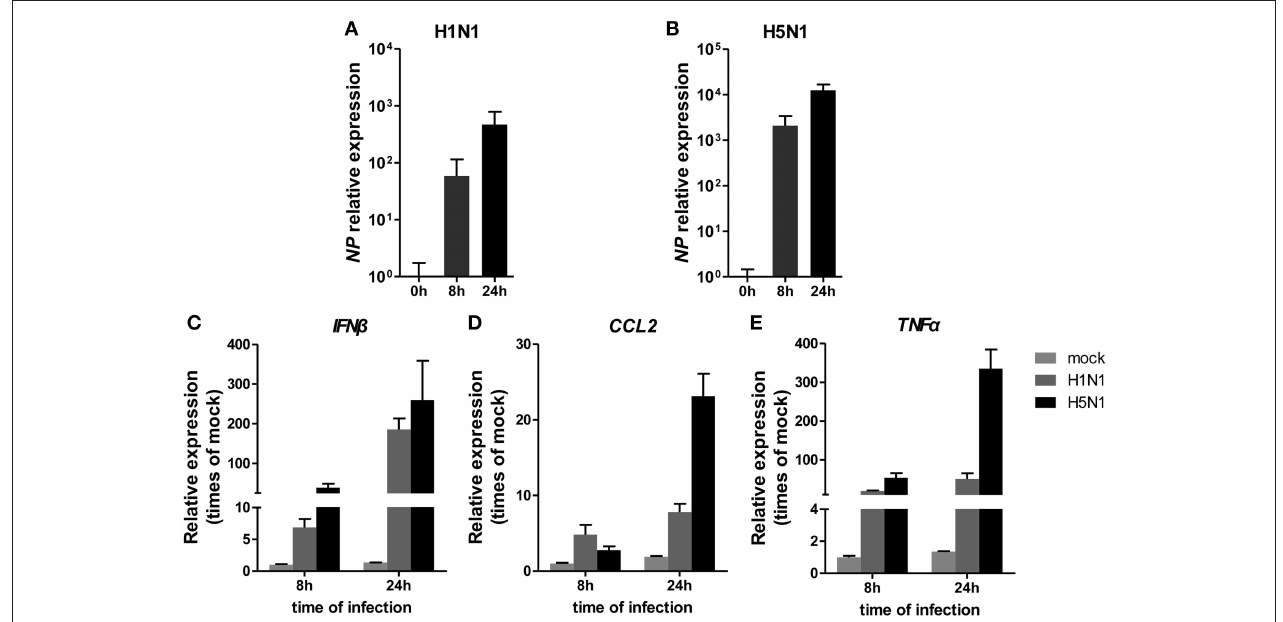
FIGURE 1 | Cellular response to IAV infection. A549 cells were uninfected or infected with A/Beijing/501/2009 (H1N1) and A/goose/Jilin/hb/2003 (H5N1) at a MOI of 5.0 for the indicated times. The relative abundance of the IAV NP gene (A,B) , IFN β (C) , CCL 2 (D), and TNF α (E) was measured by real-time qPCR and normalized to that of GAPDH . Data are the mean ± SD of three independent